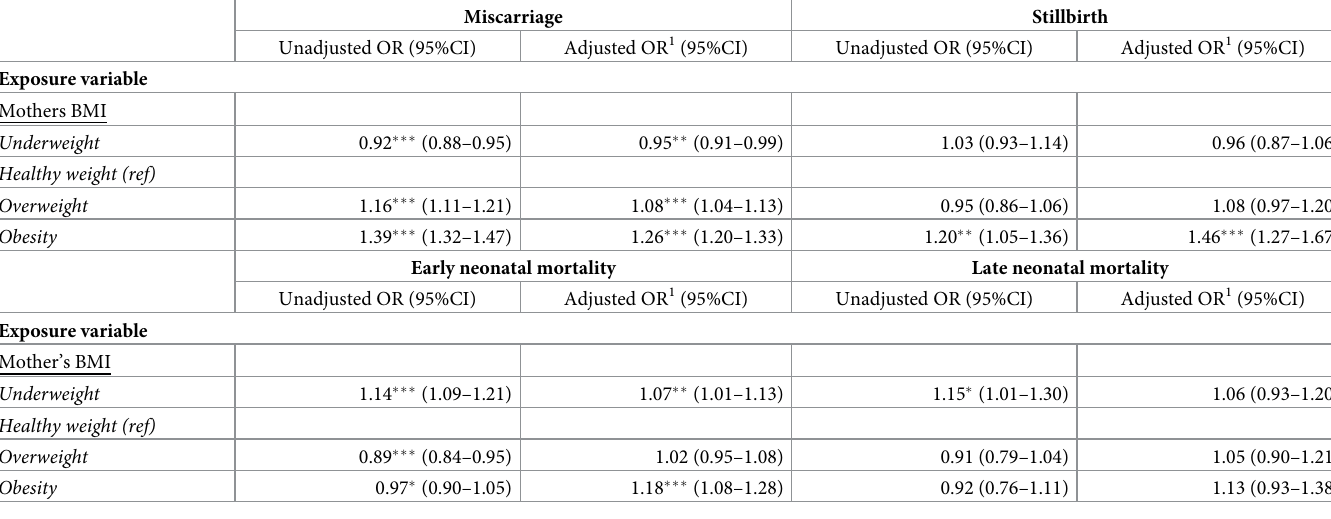
Table 3. Multivariate analysis using logistic regression for fetal and neonatal